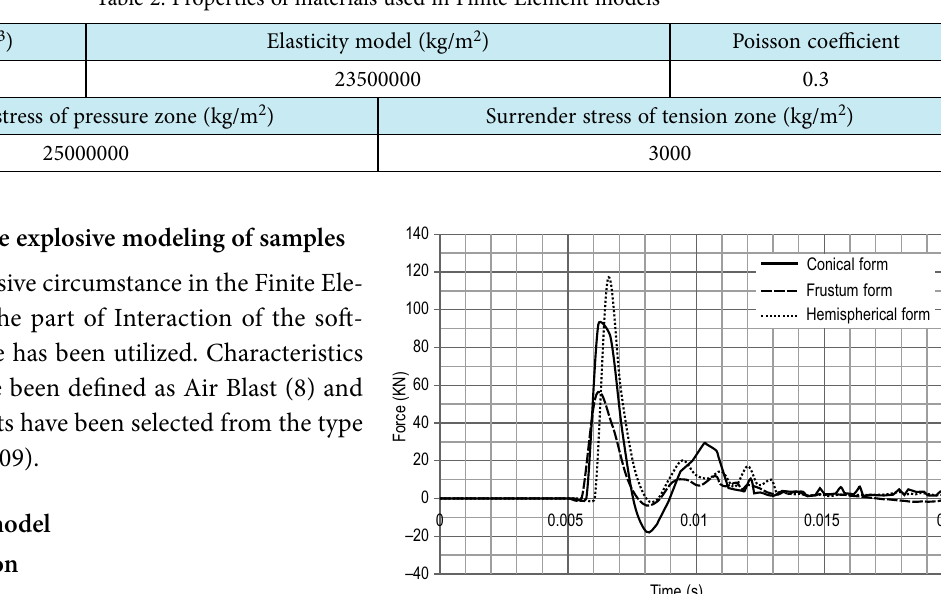
Fig 2. The comparison of kinds of construction shapes due to explosion on the ground